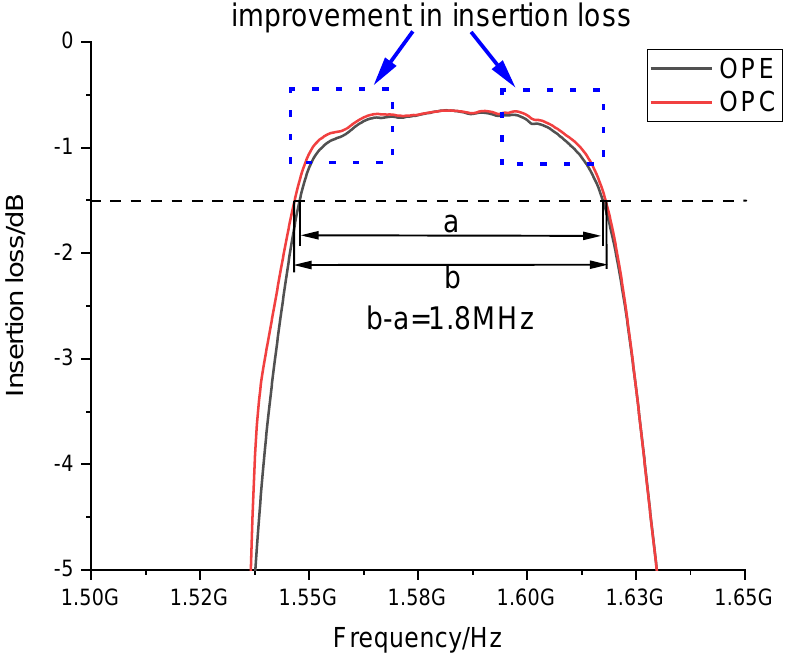
Figure 12. Insertion loss − frequency relationship before and after OPC.